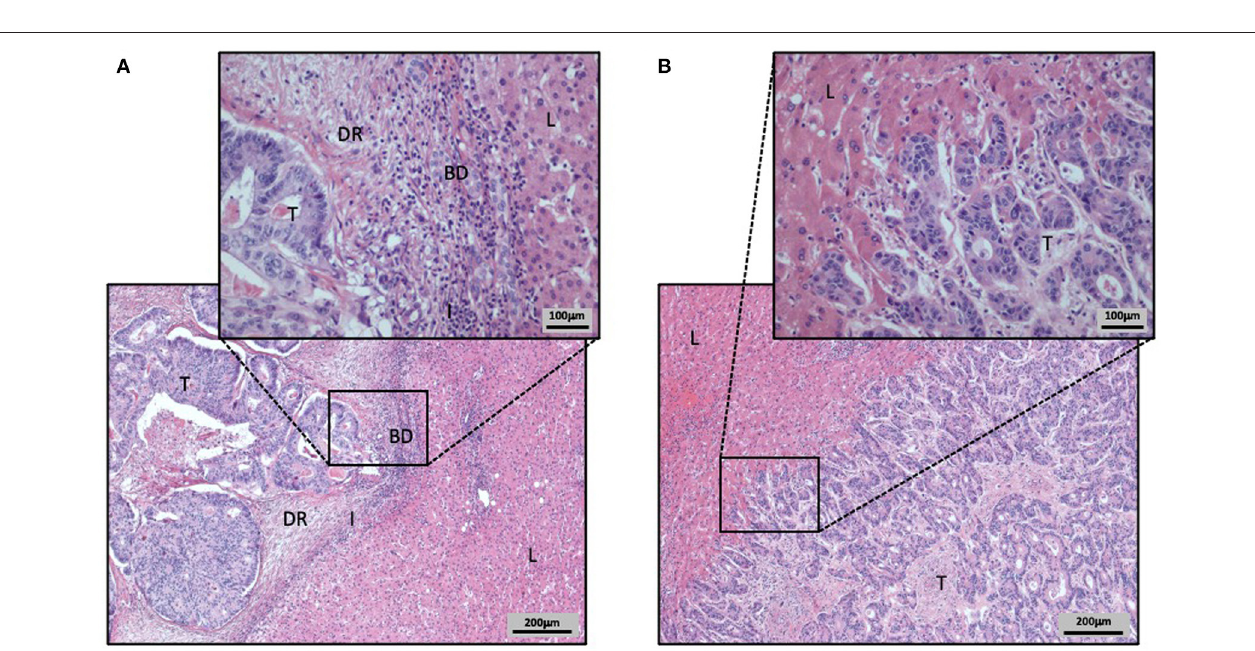
FIGURE 3 | Hematoxylin and Eosin stained CRCLM with different HGP (A,B) . Liver tissue is labeled as L, tumor tissue as T, ductular reaction of bile ducts as BD, the immune cell infiltration as I, and the desmoplastic rim as DR. (A) CRCLM with desmoplastic HGP. The CRCLM is differentiated from the surrounding liver tissue by the HGP defining desmoplastic rim. Additionally, in the desmoplastic rim the ductular reaction, composed by proliferating bile ducts, and the inflammatory infiltration are visible. (B) CRCLM with replacement HGP. The close cell–cell contact of tumor cells and hepatocytes is clearly visible, as the tumor cells invade the liver cell